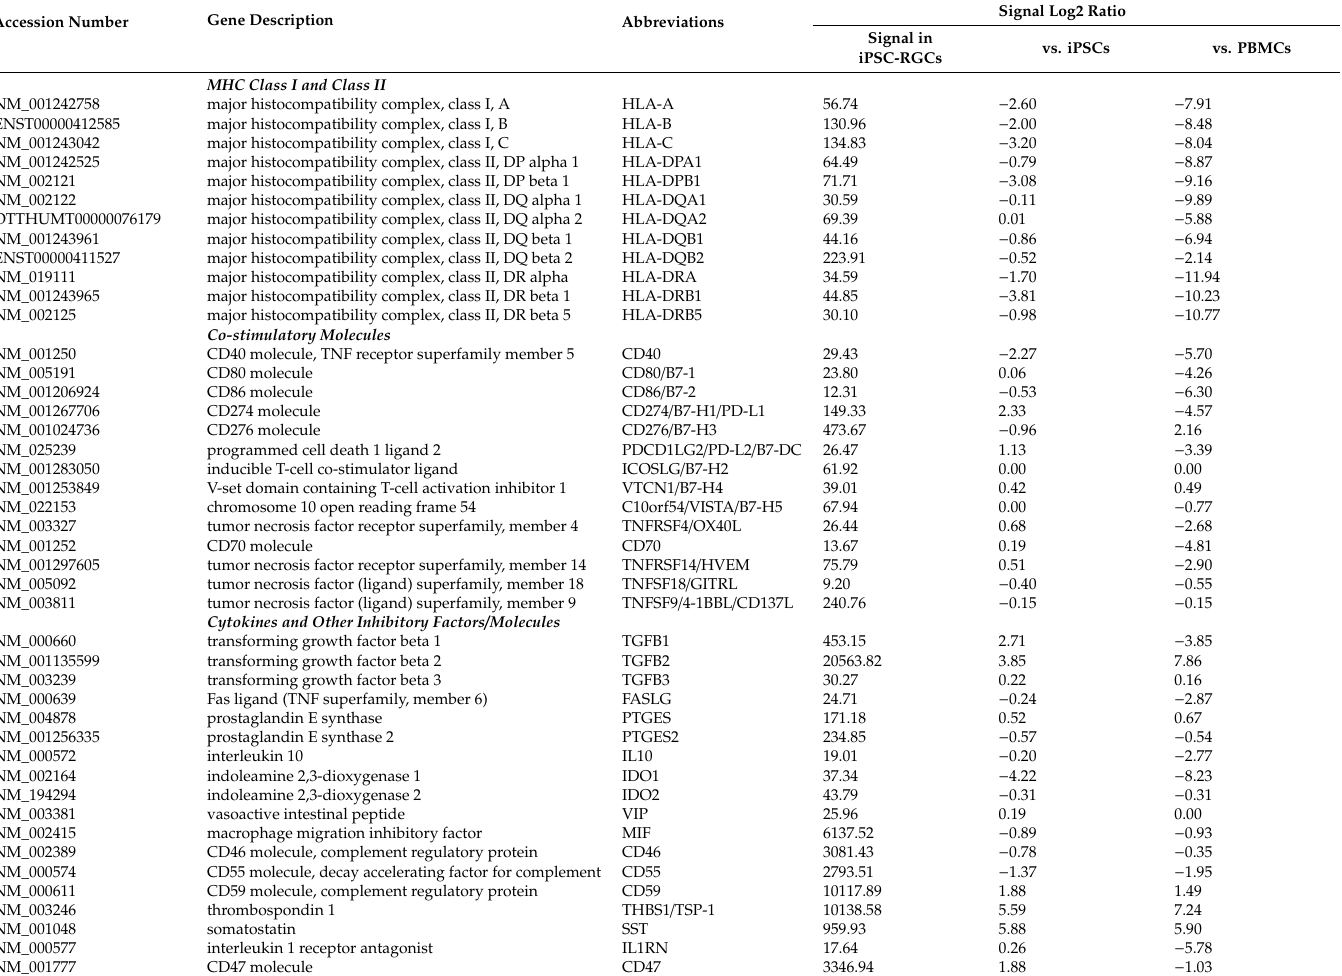
Table 1. Expression of genes related to immunogenicity and the immunosuppressive e ff ect of iPSC-RGCs according to DNA microarray